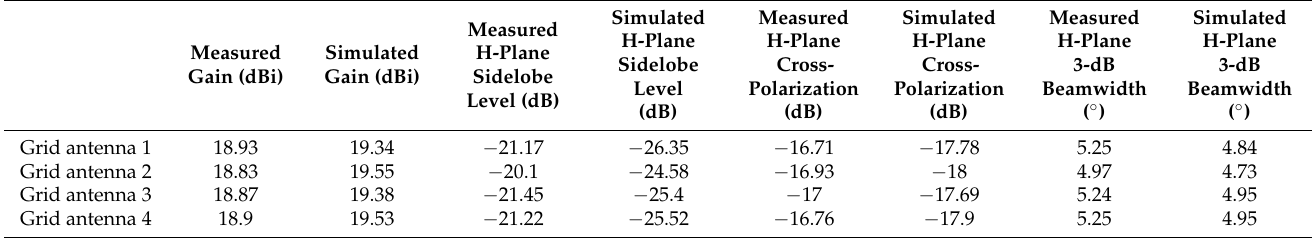
Figure 23. Comparison between measured and simulated H-plane cross-polarization patterns of every antenna element in sparse array: ( a ) grid antenna 1; ( b ) grid antenna 2; ( c ) grid antenna 3; ( d ) grid antenna 4. Table 6. Measured and simulated results of H-plane patterns for every antenna element in sparse array.